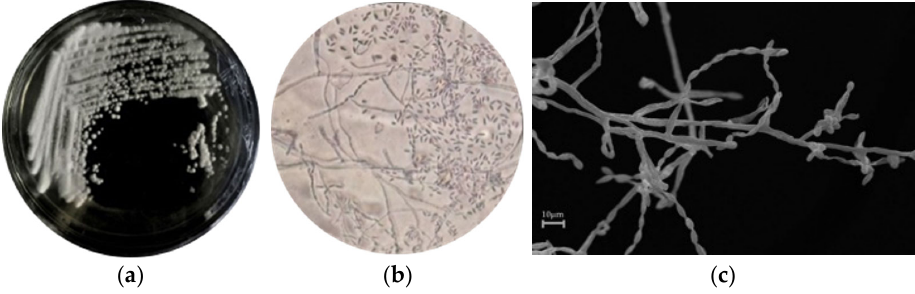
Figure 1. ( a ) Isolate 19C38A1 in colloidal chitin agar media 1%; ( b ) visualization of 19C38A1, with light microscopic scale 400×; ( c ) SEM image of aerial hyphae isolate 19C38A1, bar 2 μ m.